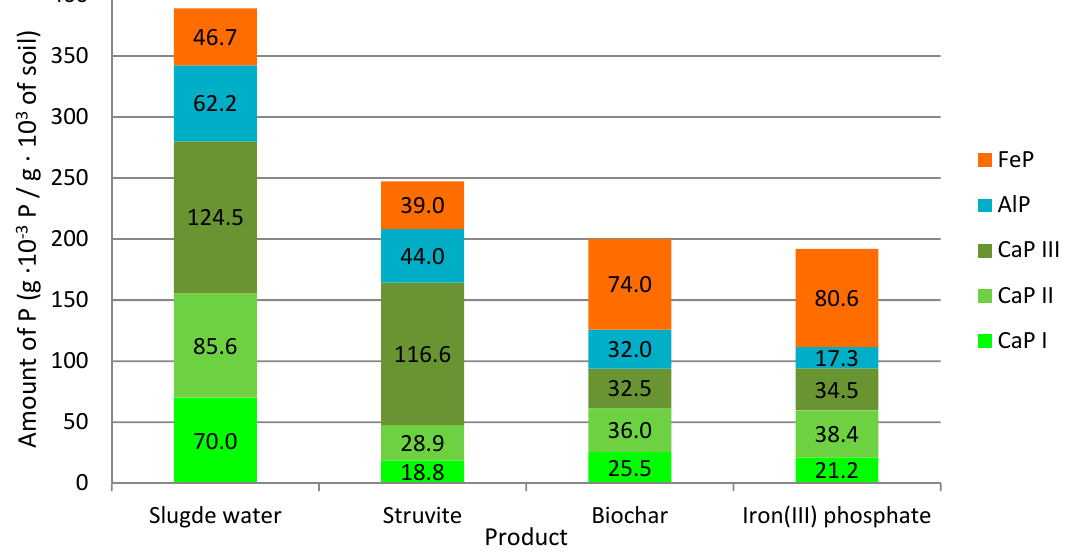
Figure 4. Fractionation of P extr into categories.